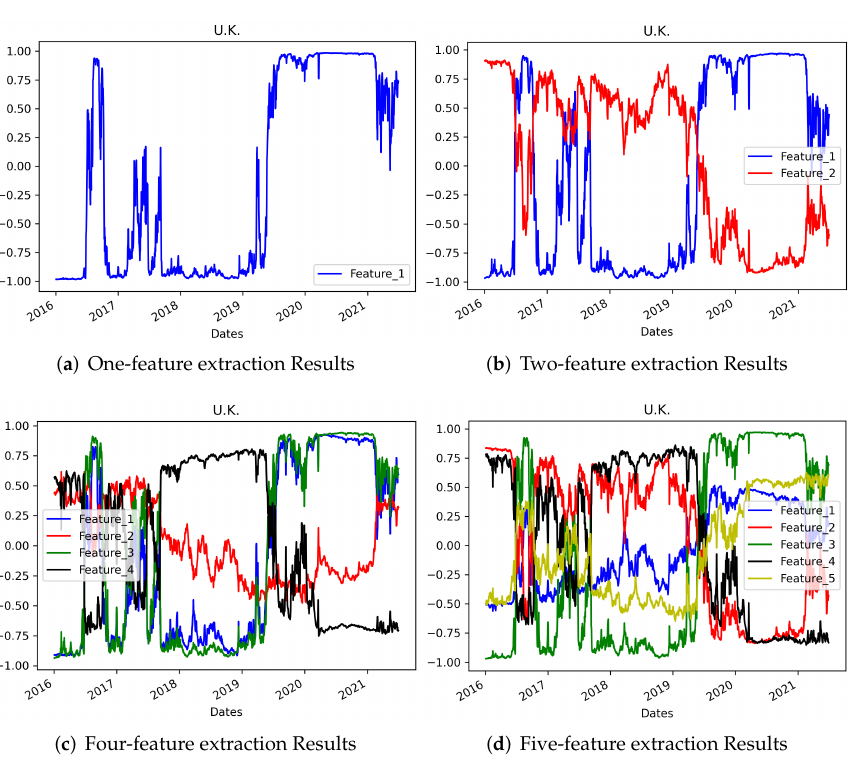
Figure 19. AE Results for the UK data with different density settings.